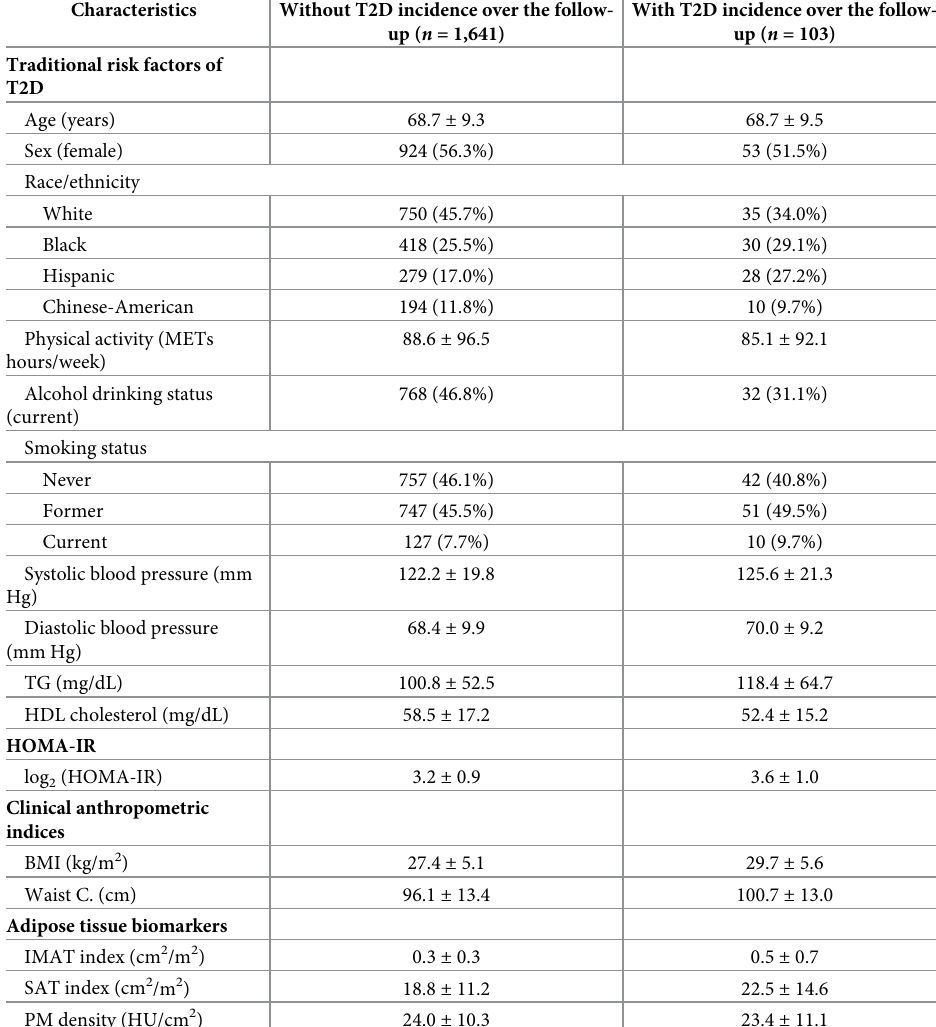
With T2D incidence over the follow- up ( n = 1,641) up ( n = 103)